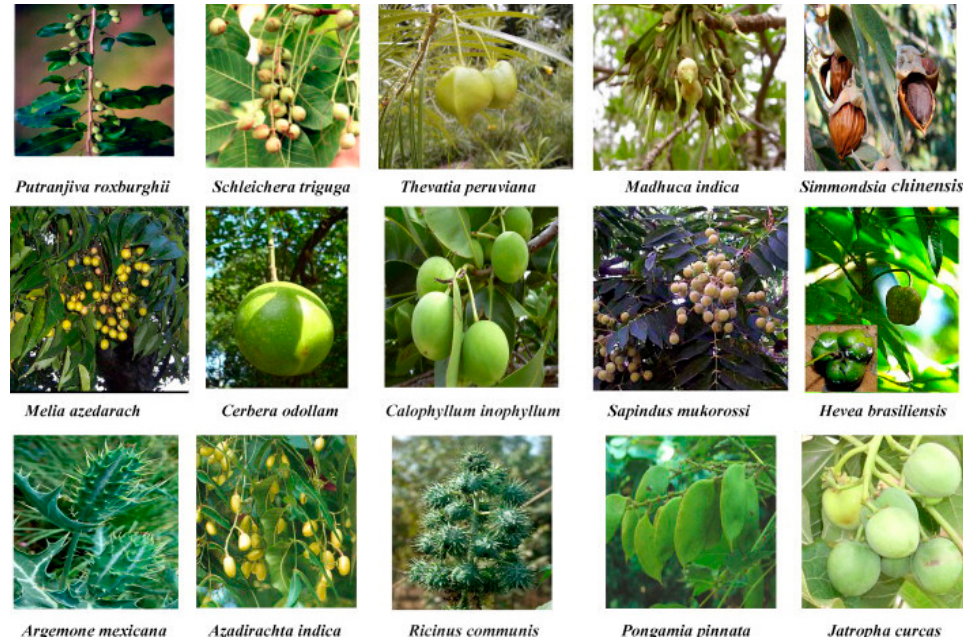
Figure 8. Feedstocks of non-edible oil for biodiesel production [127]. Table 5. Properties of second-generation biodiesel